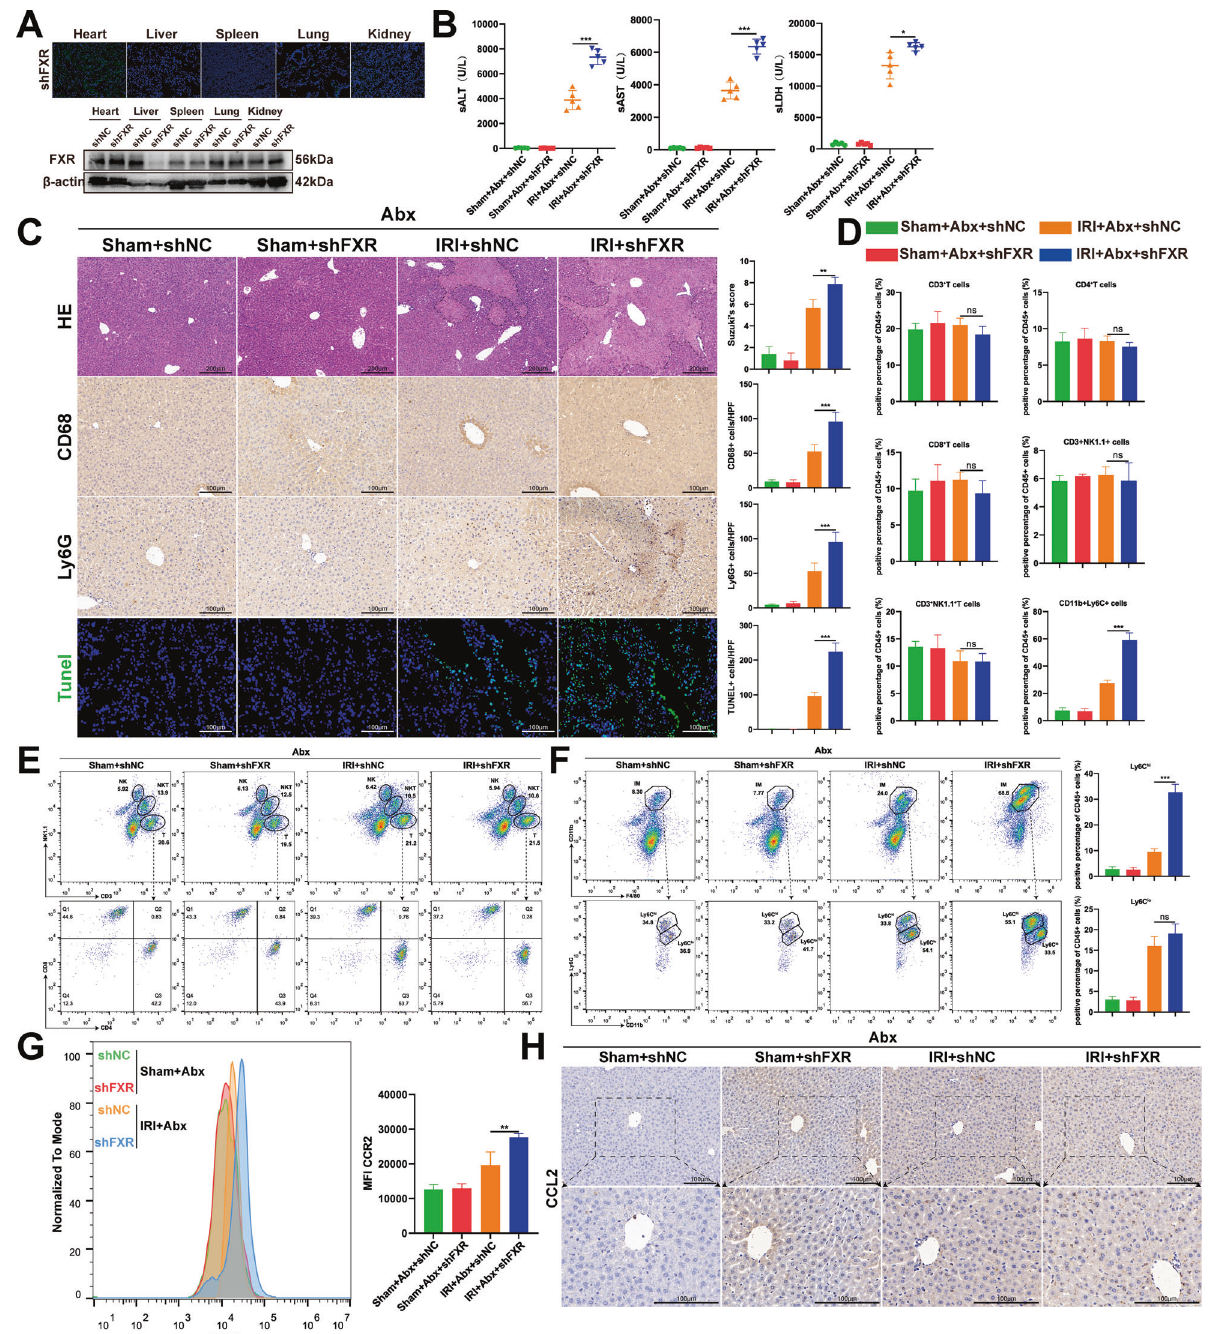
Fig. 4 Liver-speci fi c FXR inhibition abolishes the Abx-mediated protective effect of hepatic IRI. A Frozen sections and protein levels con fi rmed liver-speci fi c inhibition of FXR. B The levels of serum ALT, AST, and LDH in AAV8 shNC- and AAV8 shFXR-injected mice were measured after IRI. C Representative H&E, CD68, Ly6G, and TUNEL staining of liver sections after IRI. Scale bars, 200, 100, 100, 100 μ m. D The proportion of NPC cells in the liver after sham and IRI modeling, including CD3 + cells, CD4 + T cells, CD8 + T cells, NK cells, NKT cells, and IMs. E , F Representative fl ow cytometry images of different NPC cell proportions in the liver after sham and IRI modeling and quantitative histogram of two subsets of IMs (Ly6C hi and Ly6C lo ). G Average fl uorescence intensity of CCR2 + monocytes in each group (gated on CD45 + CD11b + cells). H Representative CCL2 IHC staining of liver sections with or without IRI in AAV8 shNC- and AAV8 shFXR-injected mice. ( n = 5 per group). Data are the mean ± SEM, ∗ p < 0.05; ∗∗ p < 0.01; ∗∗∗ p < 0.001 by unpaired Student ’ s t in Abx-treated IRI mice. IHC staining demonstrated that FXR knockdown could accelerate the secretion of CCL2 (Fig. 2H) in Abx-treated IRI mice. These data suggested that the Abx- mediated protective role of hepatic IRI was mainly due to the cytometry. Figure 4F, G con fi rmed that FXR knockdown could activation of liver FXR. upregulate the proportion of hepatic IMs and CCR2 + monocytes